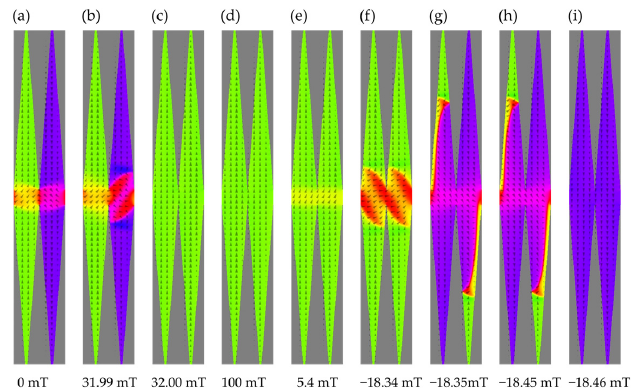
Figure 6. Magnetization maps for a pair of macrospins at the separation distance d = 0. ( a ) starting relaxed quasiAF configuration, ( b , c ) just before and just after the AF → FM switching, ( d ) at the largest applied field, ( e ) a precursor deviation in FM configuration ( f – i ) consecutive stages of the FM → rFM switching. Intensity of the applied field is given below each panel.